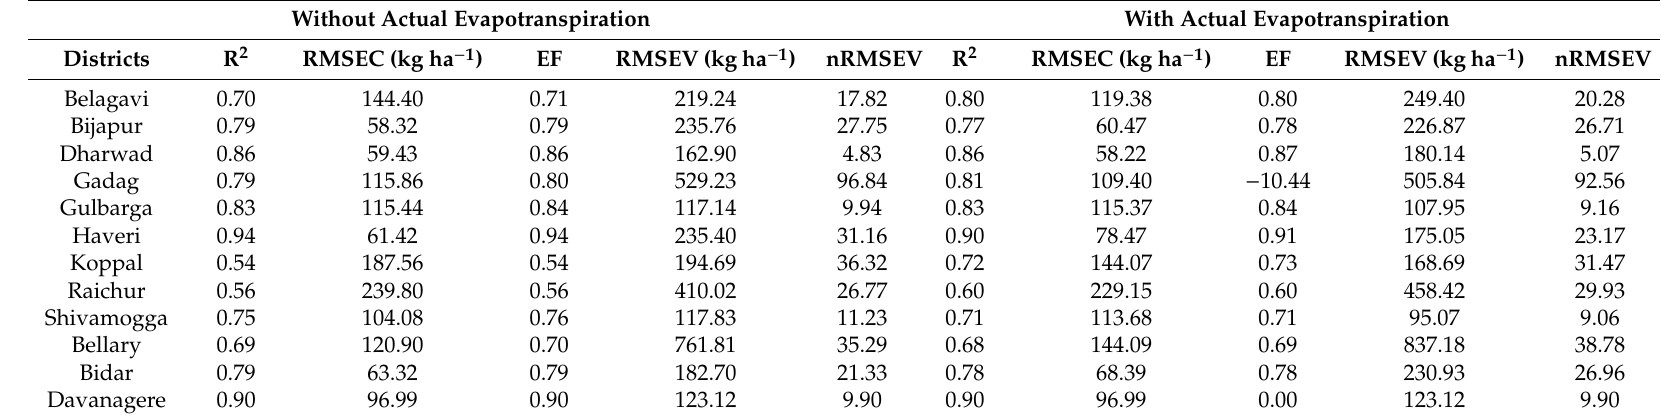
Table 5. Quantitative measures obtained for sorghum yield prediction of Karnataka using PCA_SMLR.